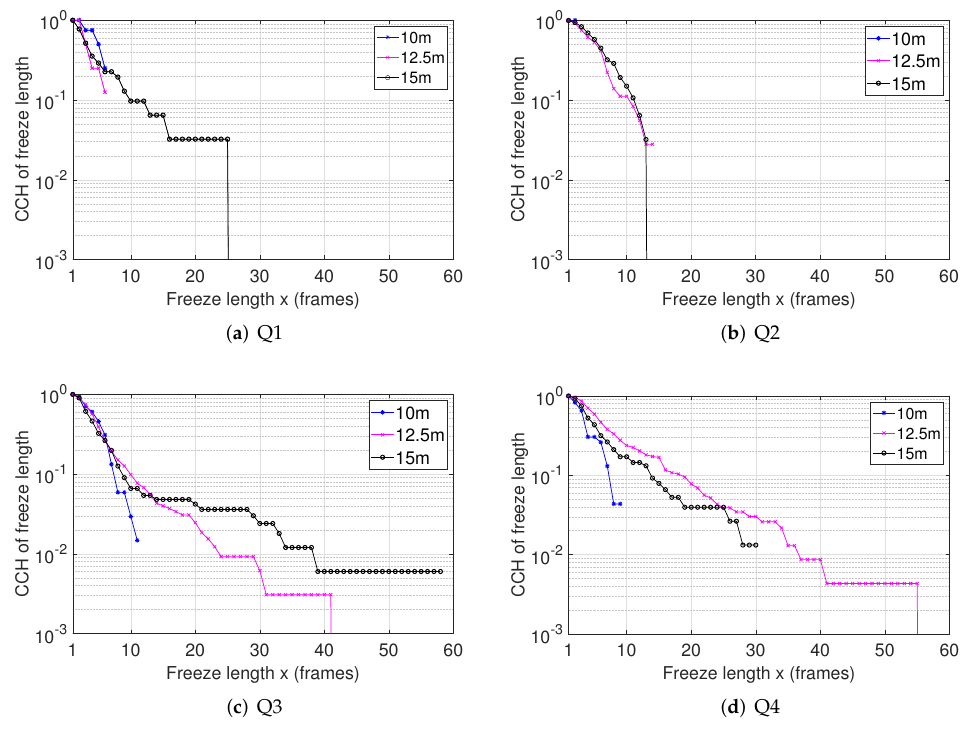
Figure 11. CCH of freeze length observed in the four